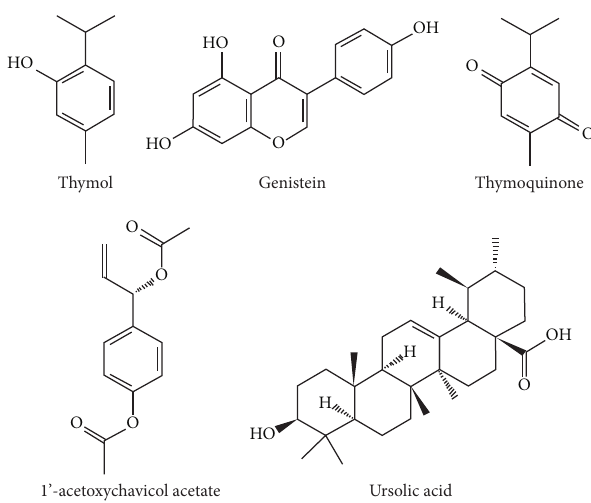
Figure 2: Chemical structures of phytoconstituents with anticancer activities (Source: PubChem). Table 2: The anticancer effects of 1 ′ -acetoxychavicol acetate on different cell lines. Cancer